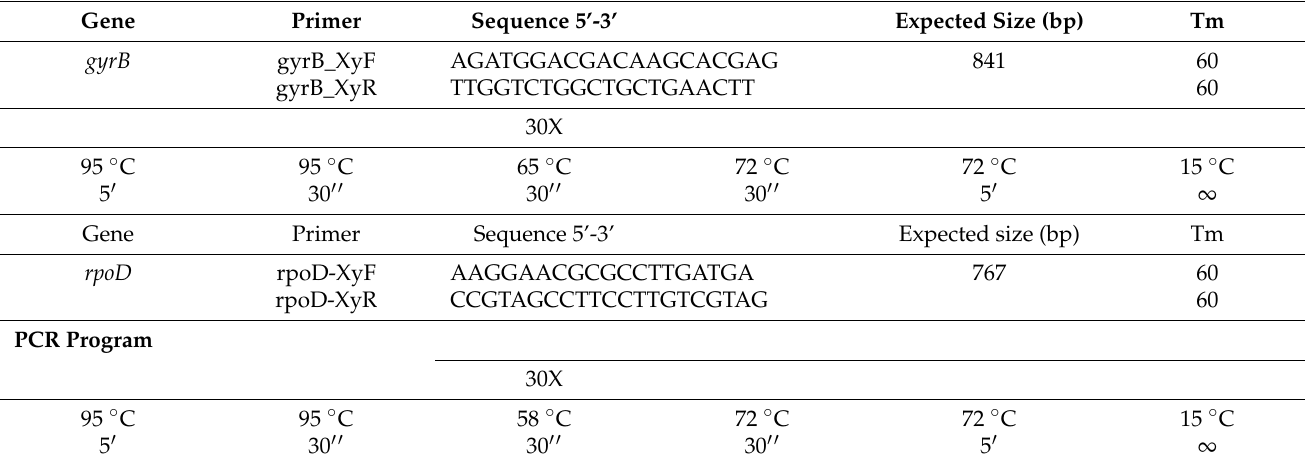
Table 2. Primer sequences and PCR programs for partial gyrB and rpoD amplification for diversity analysis of Xylophilus ampelinus